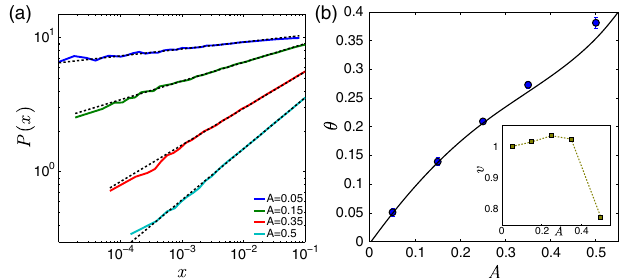
FIG. 4. (a) P ð x Þ for μ ¼ 1 , N ¼ 512 2 with different A . (b) Dependence of θ on A for μ ¼ 1 . The blue dots are the numerical values extracted from (a), and the black line is the theoretical prediction Eq. (19) using the five measured values of v (see inset) and a fifth-order polynominal interpolation to guide the eye.